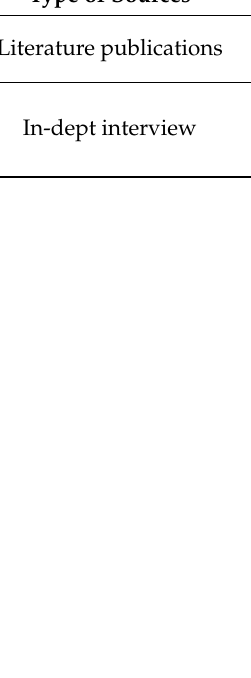
Table 2. Keys barriers to the WtE project development in